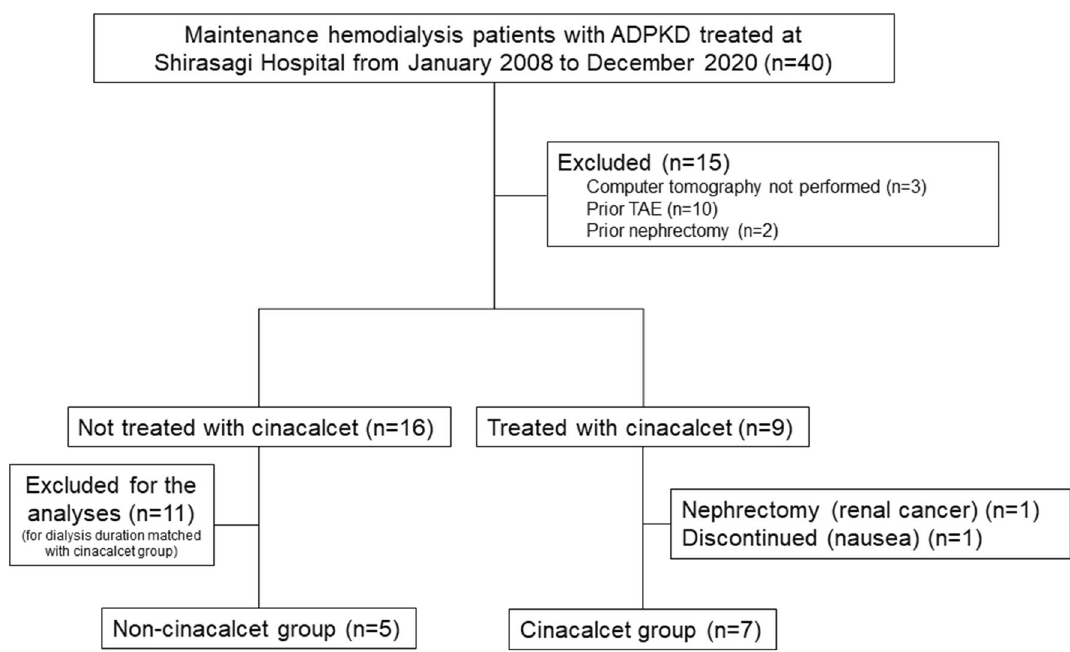
Figure 1. Flow of subject selection. This was a retrospective study of maintenance hemodialysis patients with ADPKD being treated at a single center, Shirasagi Hospital. Seven patients received and could continue cinacalcet treatment (cinacalcet group). Sixteen patients did not receive cinacalcet treatment. Of the 16, 5 patients (non-cinacalcet group) were chosen to match hemodialysis duration with the cinacalcet group.